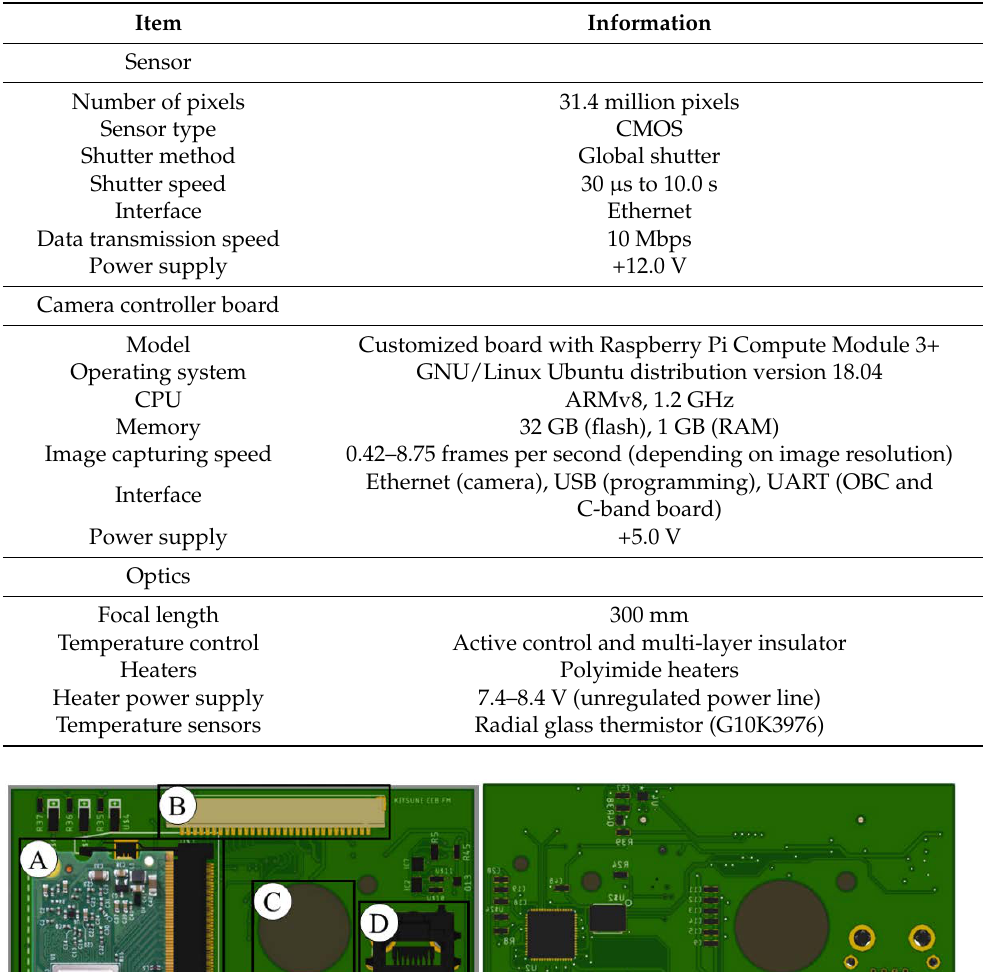
Table 1. Imaging payload properties.